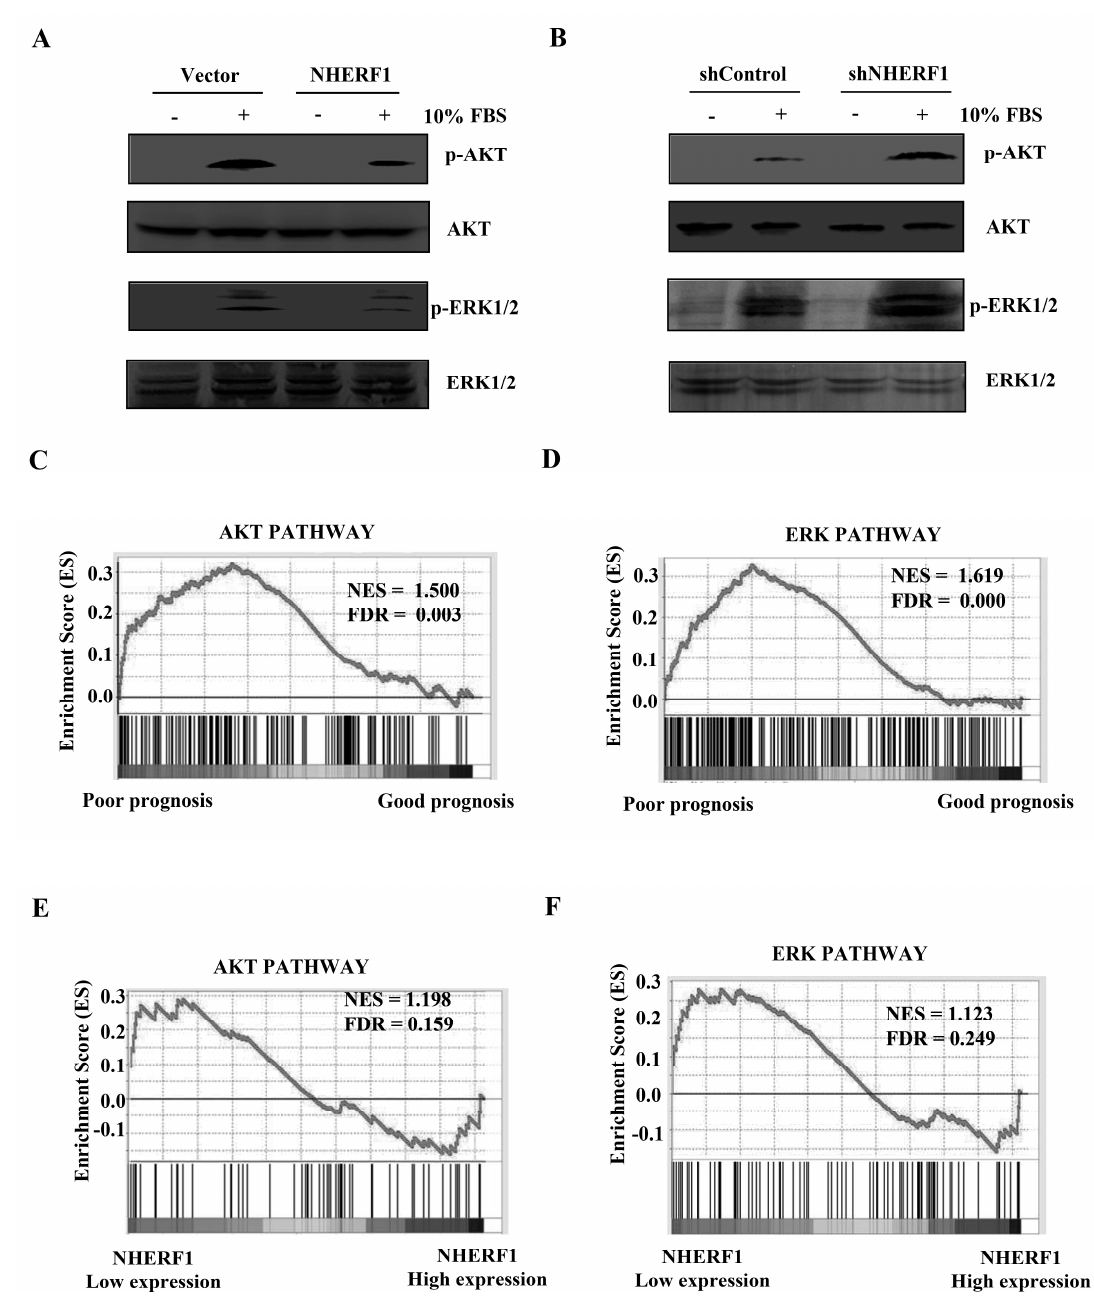
Figure 4. NHERF1 regulates AKT and ERK signaling pathways in cisplatin-resistant cervical cancer